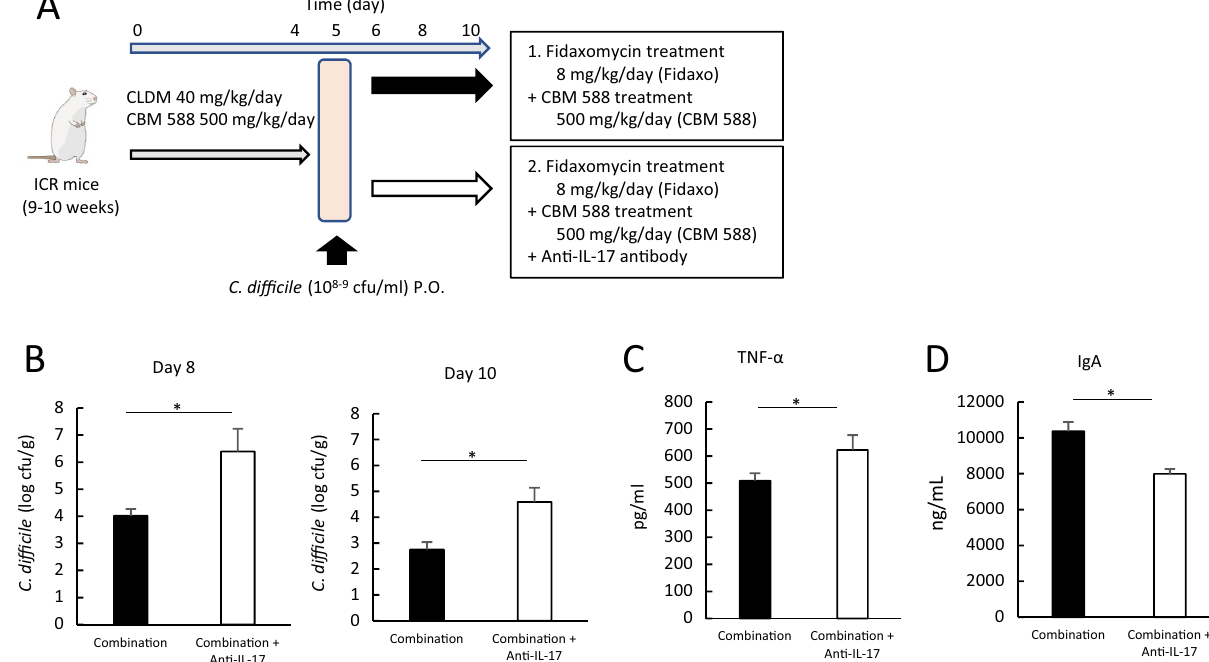
Figure 6. C. butyricum upregulated IL-17A in the cLP to increase IgA production under CDI. ( A ) Experimental design of fidaxomicin and CBM 588 administration with/without anti-IL-17A antibody in 9- to 10-week-old ICR Swiss mice. ( B ) Assessment of C. difficile in feces at day 8 and 10. 1: combination (CBM 588 + fidaxomicin) group (Combination), 2: combination group + anti-IL-17A antibody. The testing detectable level is above 2.0 (log amount) per gram of feces, data shown as mean ± SD (n = 5–10 per group). ( C ) Tumor necrosis factor-α (TNF-α) and ( D ) Immunoglobrin A (IgA) protein concentrations in mice colon tissue detected at day 8. All values are mean ± SD (n =